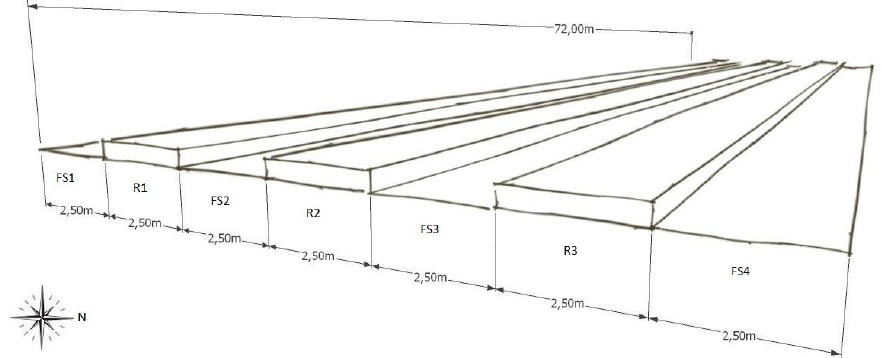
Figure 1. General layout of the experimental field indicating the soil surface shaping, with four flat areas (FS1–4) and three raised beds (R1–3). This is the innovative MITIORG organic long-term field experiment ( Long-term climatic change adaptation in organic farming: synergistic combination of hydraulic arrangement, crop rotations, agro-ecological service crops and agronomic techniques ), located on the research farm ‘Azienda Sperimentale Metaponto’ of the Council for Agricultural Research and Economics, Research Centre for Agriculture and Environment (CREA-AA) (Metaponto—MT, Italy; lat. 40°24′ N; long. 16°48′ E). 2,50 m = 2.50 m; 72,00 m = 72.00 m.